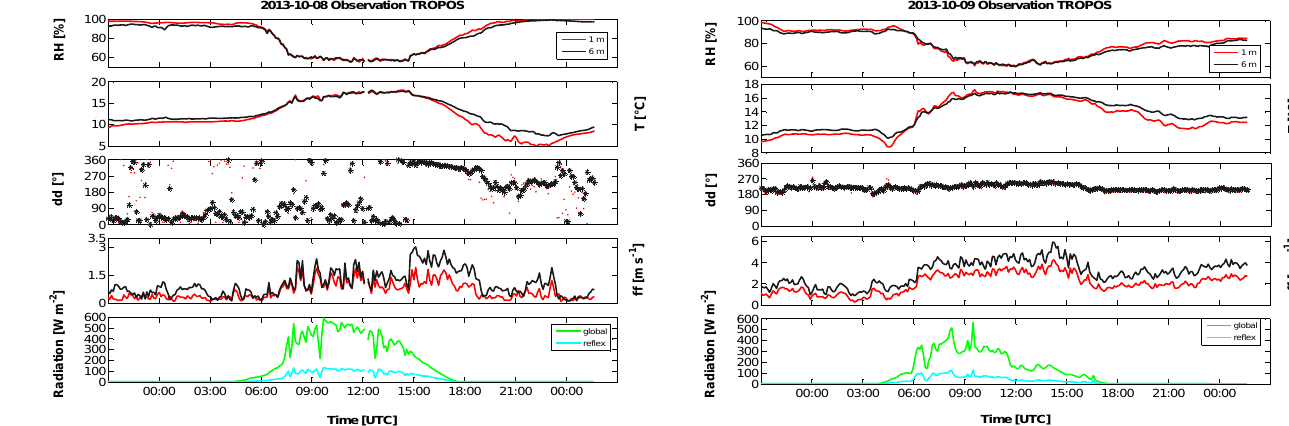
Figure 6. Meteorological parameters at the research site in Melpitz on 8 October 2013. The depicted time range is from 00:00 to 23:50 UTC with 5min intervals. The data contain measurements of rela- tive humidity (RH), temperature ( T ), wind direction (dd) and wind speed (ff) in the height of 1m (red line, red stars) and 6m (black line, black dots) above ground. Further global solar radiance (green line) and reflected global radiation (blue line) are recorded in the short-wave range.